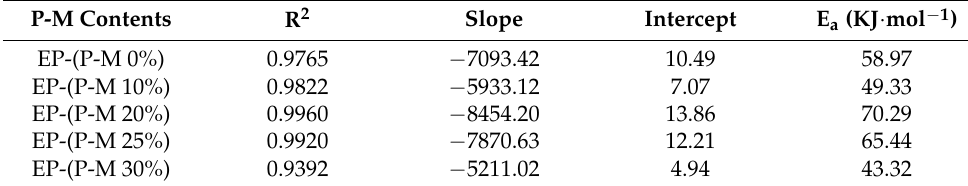
Table 1. The thermal degradation kinetic parameters for the Kissinger method.